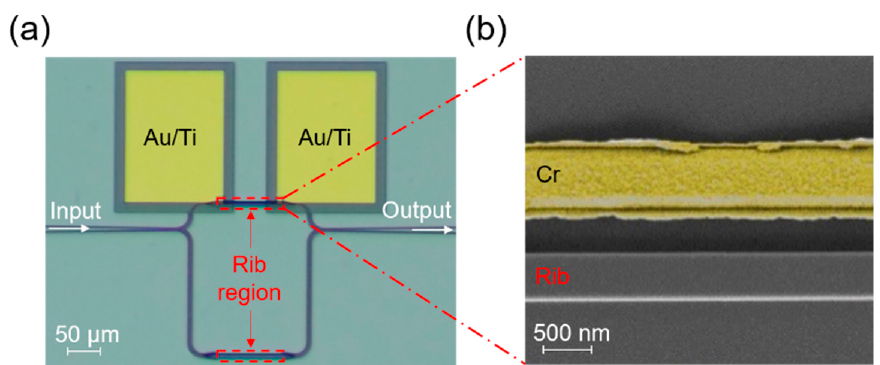
Figure 4. ( a ) Microscope image of the MZI structure. ( b ) The zoom in SEM image of the phase shifter. Cr heater is false colored.